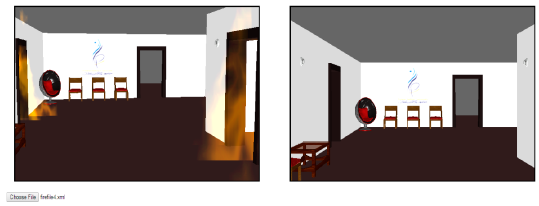
Figure 13. The 3D modeling system output.